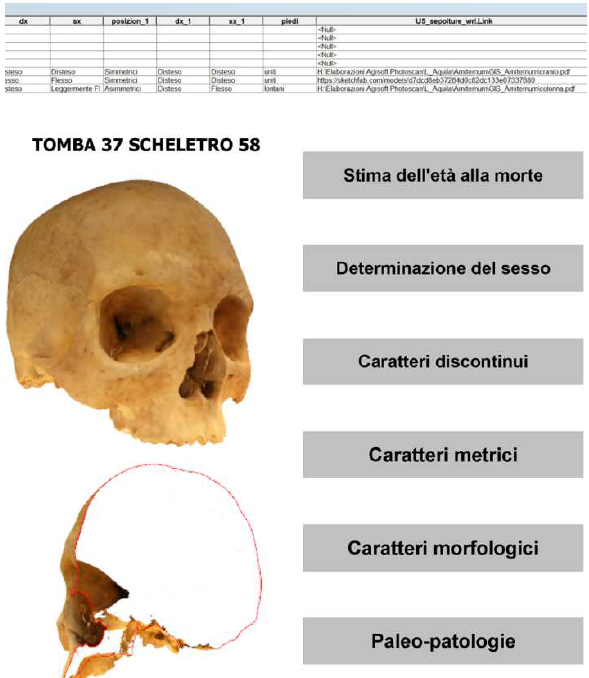
Figure 7. Database with the hyperlink and view of the pdf3D with 3D model of skull and its data.